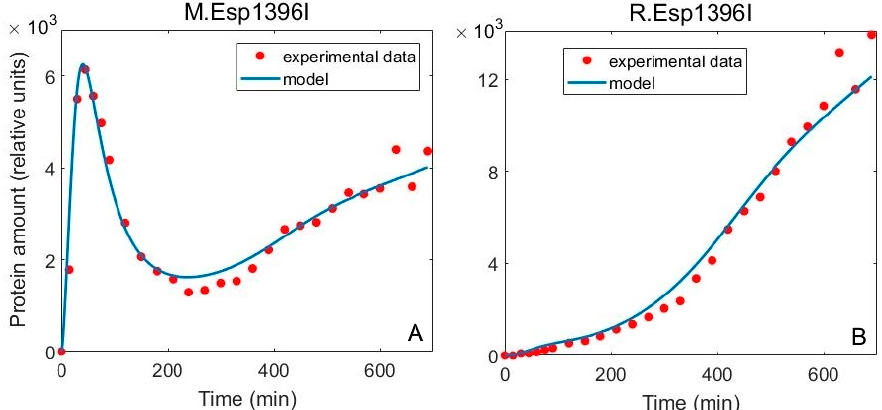
Figure 3. Comparison of the model with included population dynamics with experimental data. Comparison of predictions for Esp1396I R-M system with experimentally measured time-dependence of protein amounts in single cells. The model (blue curve) is fitted to experimental data (red dots) for ( A ) methyltransferase (adjusted R 2 = 0.97) and ( B ) restriction endonuclease dynamics (adjusted R 2 = 0.98).